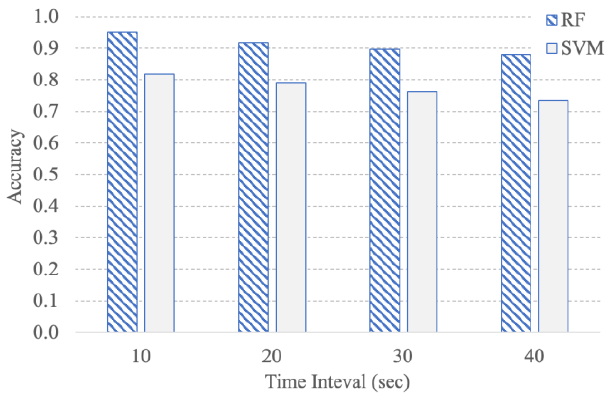
Figure 12. The accuracy values of time Figure 12. The accuracy values of time intervals. Figure 12. The accuracy values of time intervals. Figure 12. The accuracy values of time intervals. Figure 12. The accuracy values of time intervals.